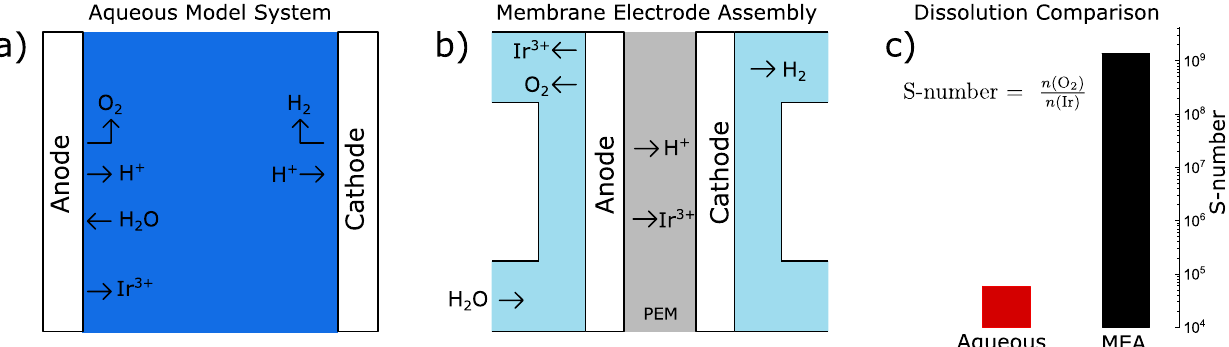
Fig. 1 Degradation processes of OER catalysts in aqueous and polymer electrolyte. a Schematic drawing of degradation processes in a classical aqueous electrolysis cell in aqueous electrolyte and b schematic drawing of degradation processes in MEA. c Dissolution stability of IrO x under OER conditions in aqueous electrolyte, measured in SFC-ICP-MS, and polymer electrolyte, measured in a precipitation-free MEA device, expressed in the S-number metric. Measurements were carried out with a 5 min chronopotentiometry hold in aqueous electrolyte and over several days for MEA, typical timescales for the devices. Source data are provided in the source data fi